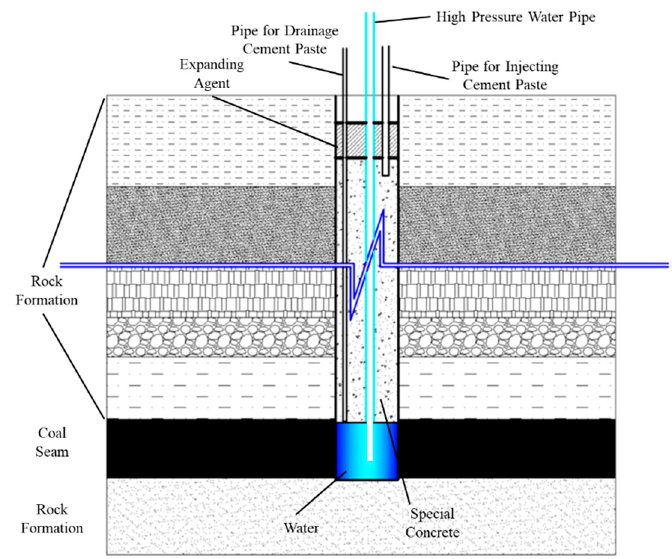
Figure 4. Sketch diagram of the seal method for hydraulic fracturing.